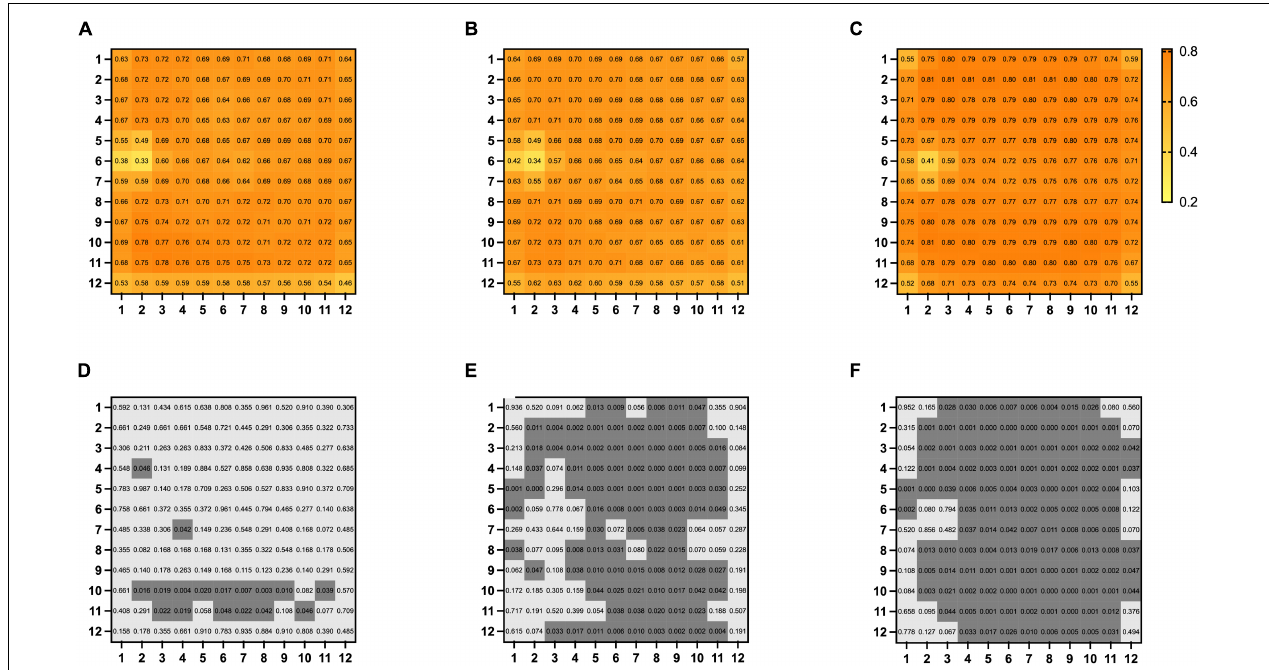
FIGURE 4 | Map of mean choriocapillary density in 12 * 12 mm grids in BRVO eyes (A) , fellow eyes (B) , and control eyes (C) . Comparison of choriocapillaris density in each of the 12 * 12 mm grids BRVO eyes and fellow eyes (D) , BRVO eyes and control eyes (E) and fellow eyes and control eyes (F) . A p -value of less than 0.05 was highlighted with a darker gray background. Presented in left eye